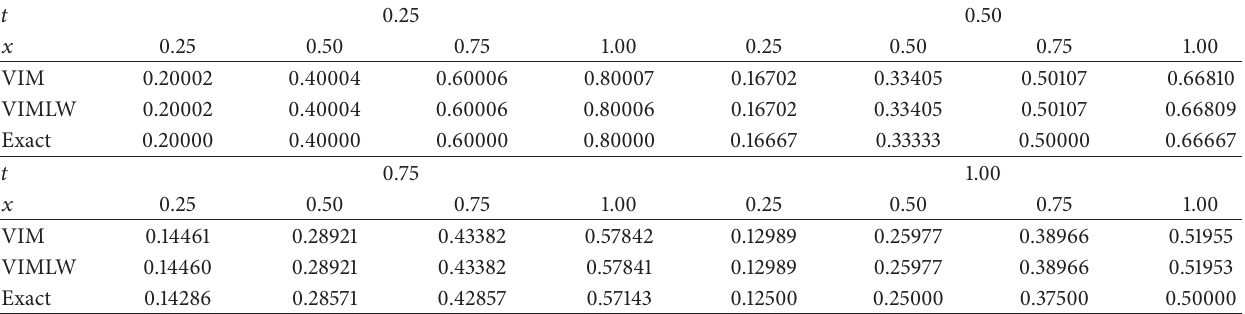
Table 1: Numerical values when 𝑡 = 0.25 , 0.50, 0.75, and 1.0 for